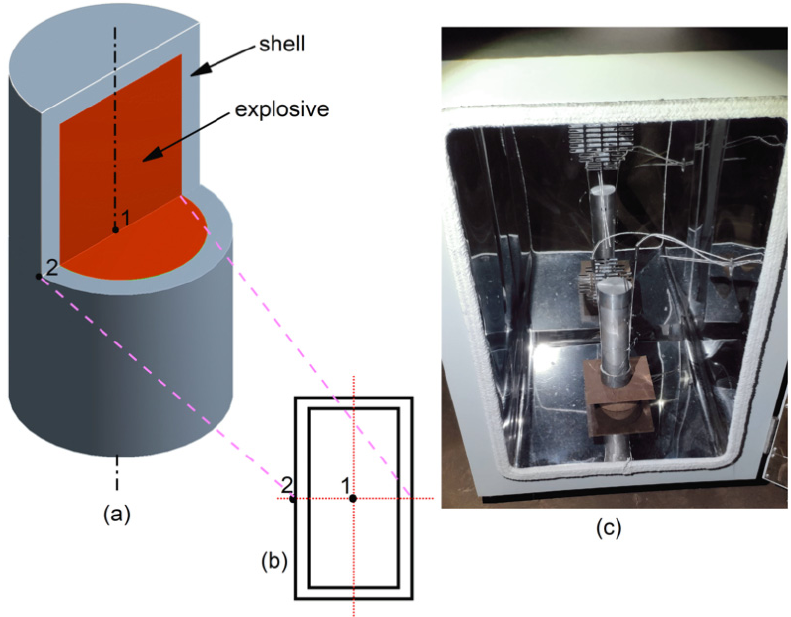
Figure 2. Experiment layout ( a ) Schematic diagram of the sample; ( b ) Schematic diagram of the location of the temperature measurement point; ( c ) Experimental device diagram.